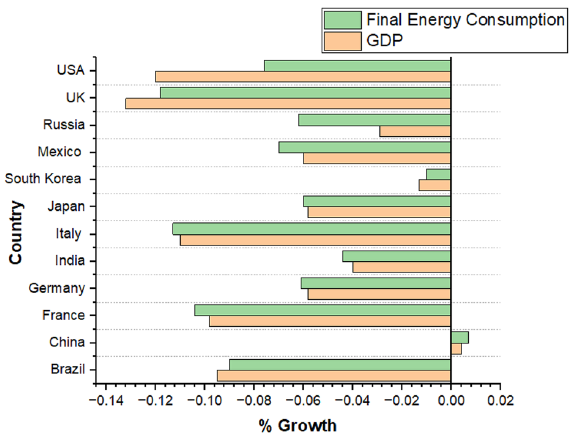
Figure 2. Relationship between energy consumption and GDP in 2020 28